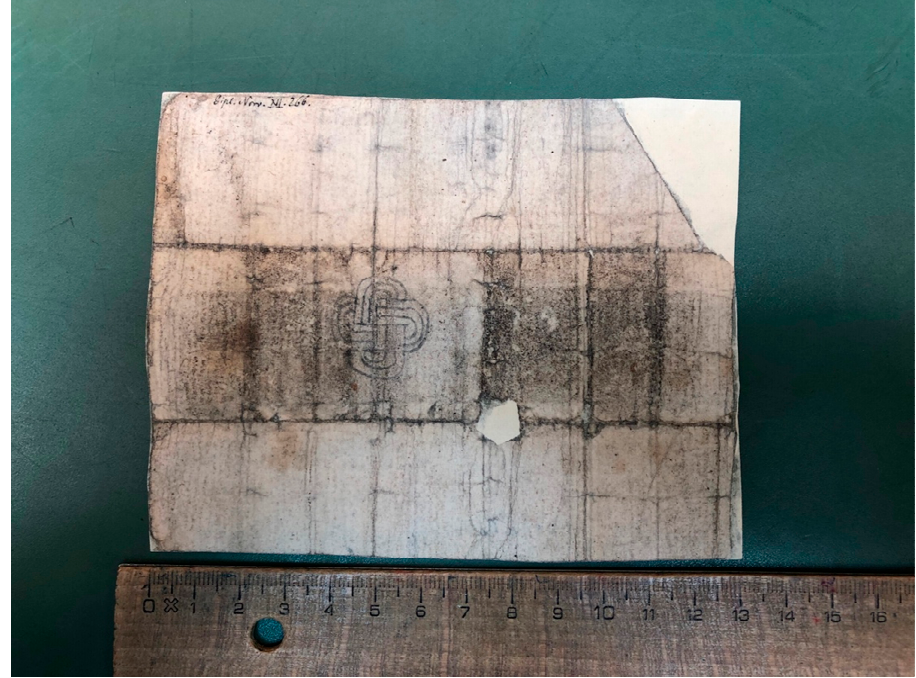
Figure 2. The amulet from Torpo, sigillum Salomonis or Salomon’s knot. Ink on paper, 1450–1500. Photo: Kaja M. H. Hagen.